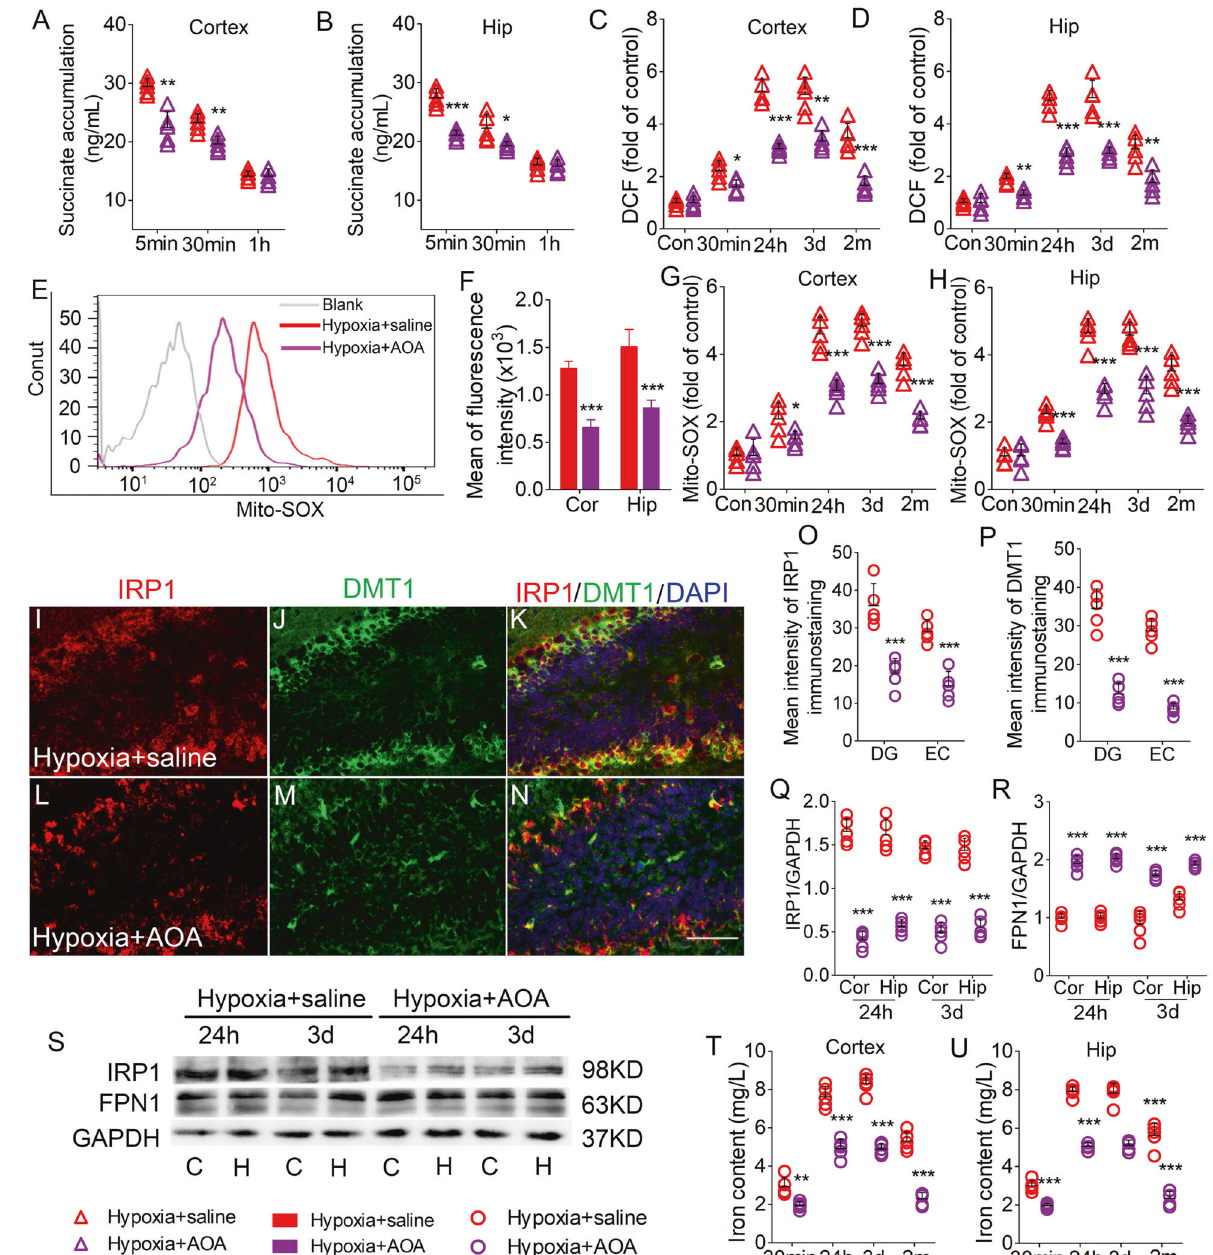
quanti fi cation of hippocampal mito-SOX level. I – N Decreased immunoreactivity of IRP1 (red) and DMT1 (green) in the DG region after AOA treatment. Blue, DAPI. O , P Changed levels of IRP1 and DMT1 in the EC and DG. Bar = 50 μ m. Q – S Expression of IRP1 and FPN1 in the cortex and hippocampus estimated using western blotting. n = 5/group. T , U Levels of iron ( n = 5 per time point). * P < 0.05, ** P < 0.01, and *** P < 0.001, all compared with hypoxia + saline group (One-way